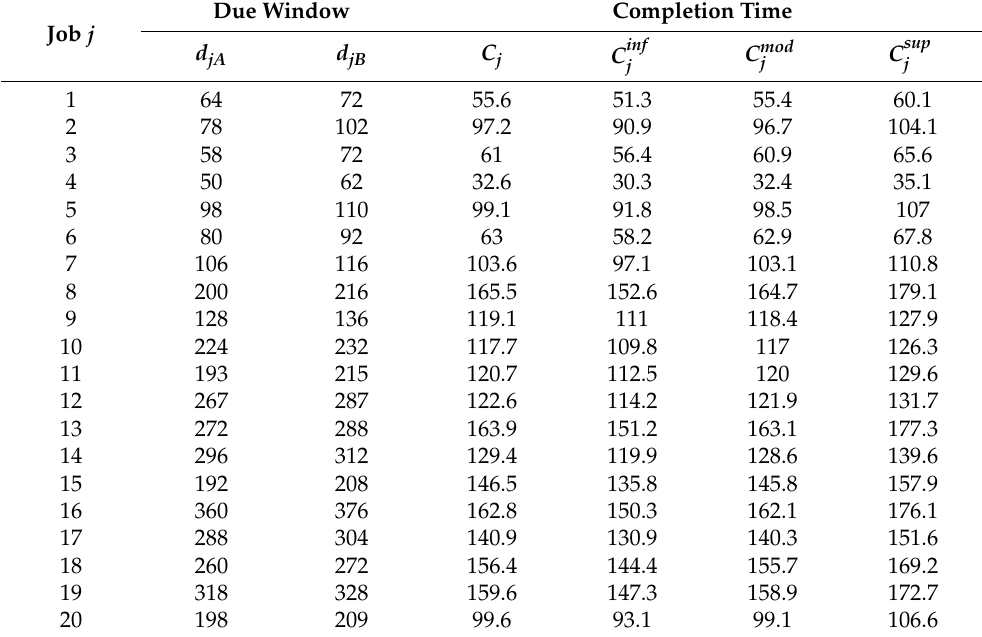
Table 3. Completion time for the best solution considering 20 jobs.